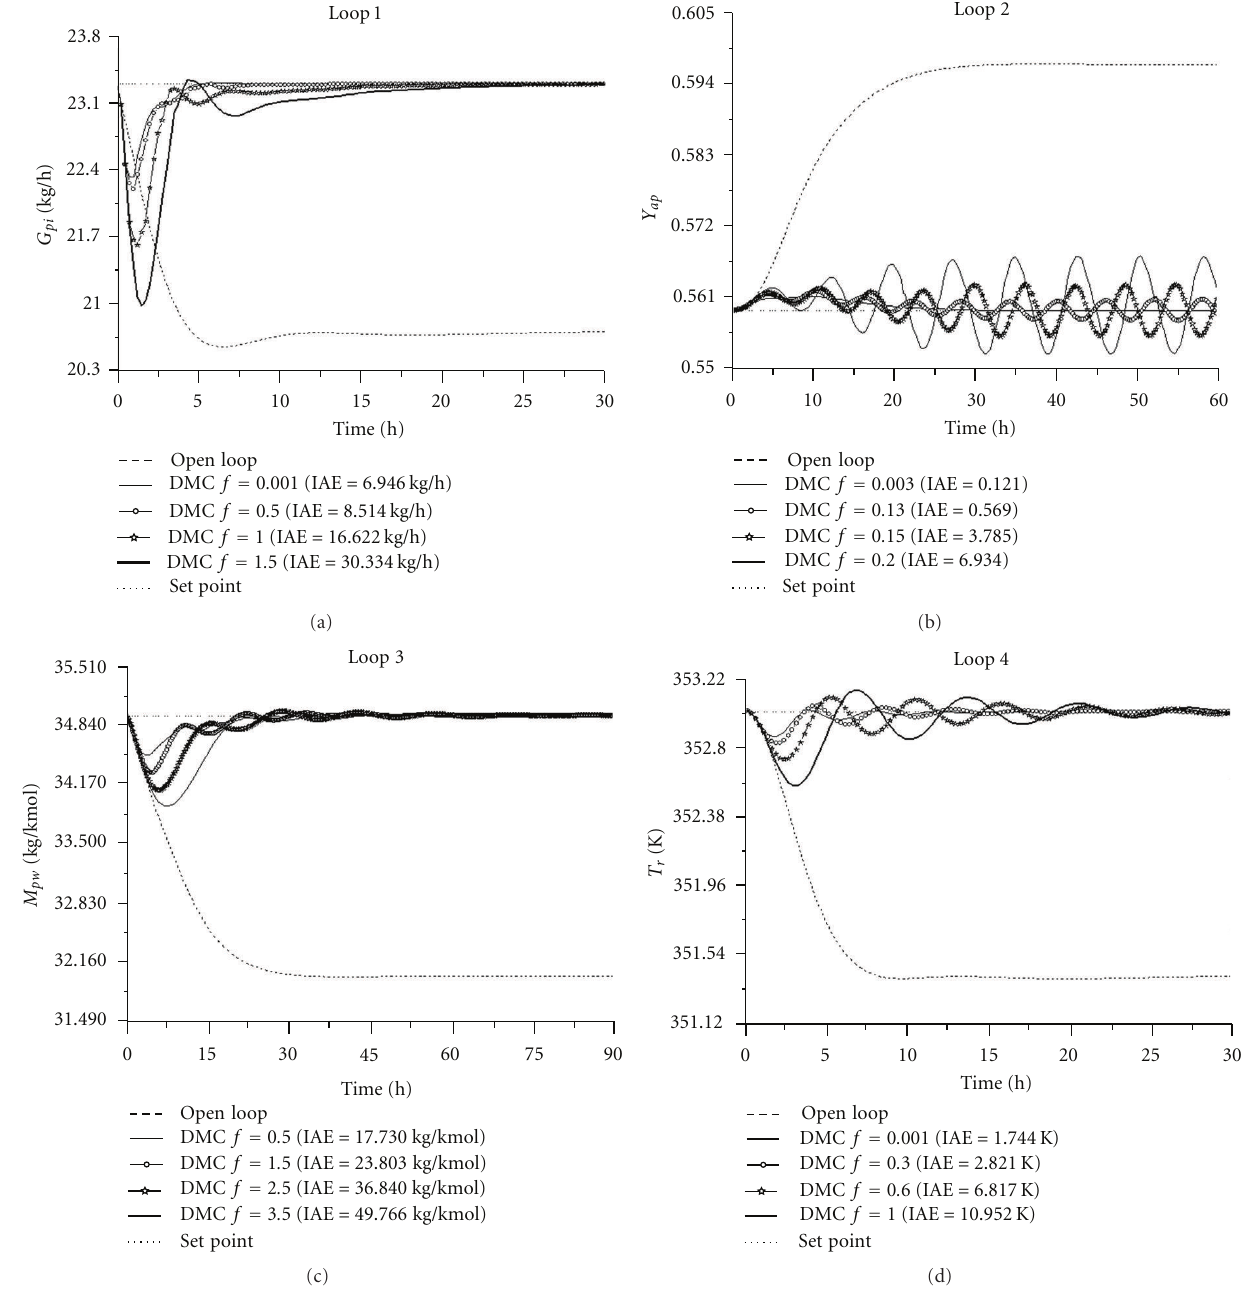
Figure 10: f sensitivity simulations for an inhibitor disturbance of 4 parts per 1000 (mole